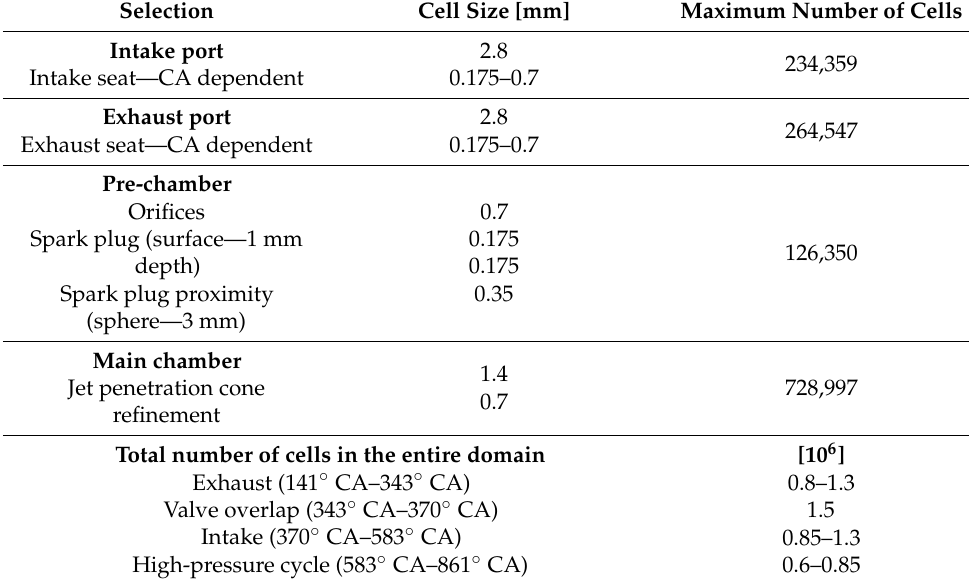
Table 3. Mesh refinement setup and the resulting mesh